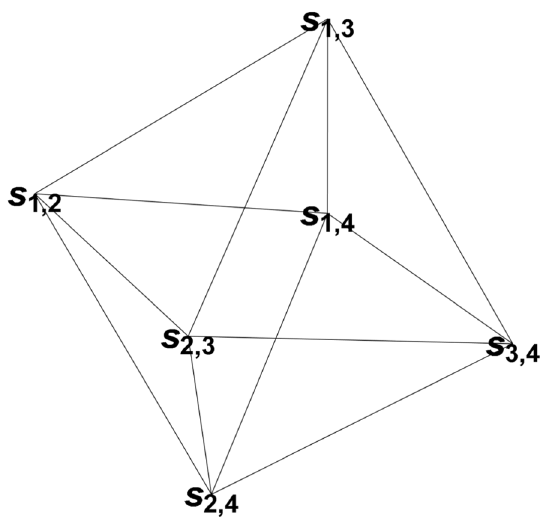
Figure 10 . Mandelstam invariants arranged on the hypersimplex ∆ 2 , 4 , the octahedron. By mo- mentum conservation, every (triangular) facet sums to